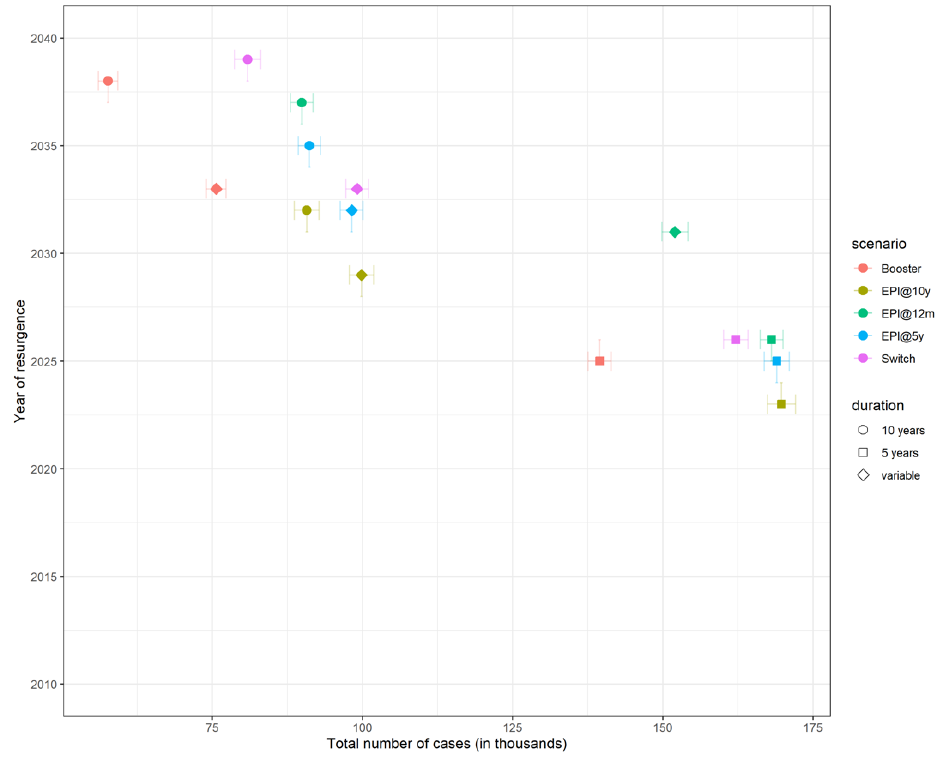
Figure 2. Total number of cases plotted against the year of resurgence across all scenarios and all assumptions regarding duration of protection and coverage. Each strategy is represented with a different colour and each assumption about the duration of protection is represented with a different symbol shape. Note that 20 years duration of protection is not shown. Error bars show the 95% confidence interval.